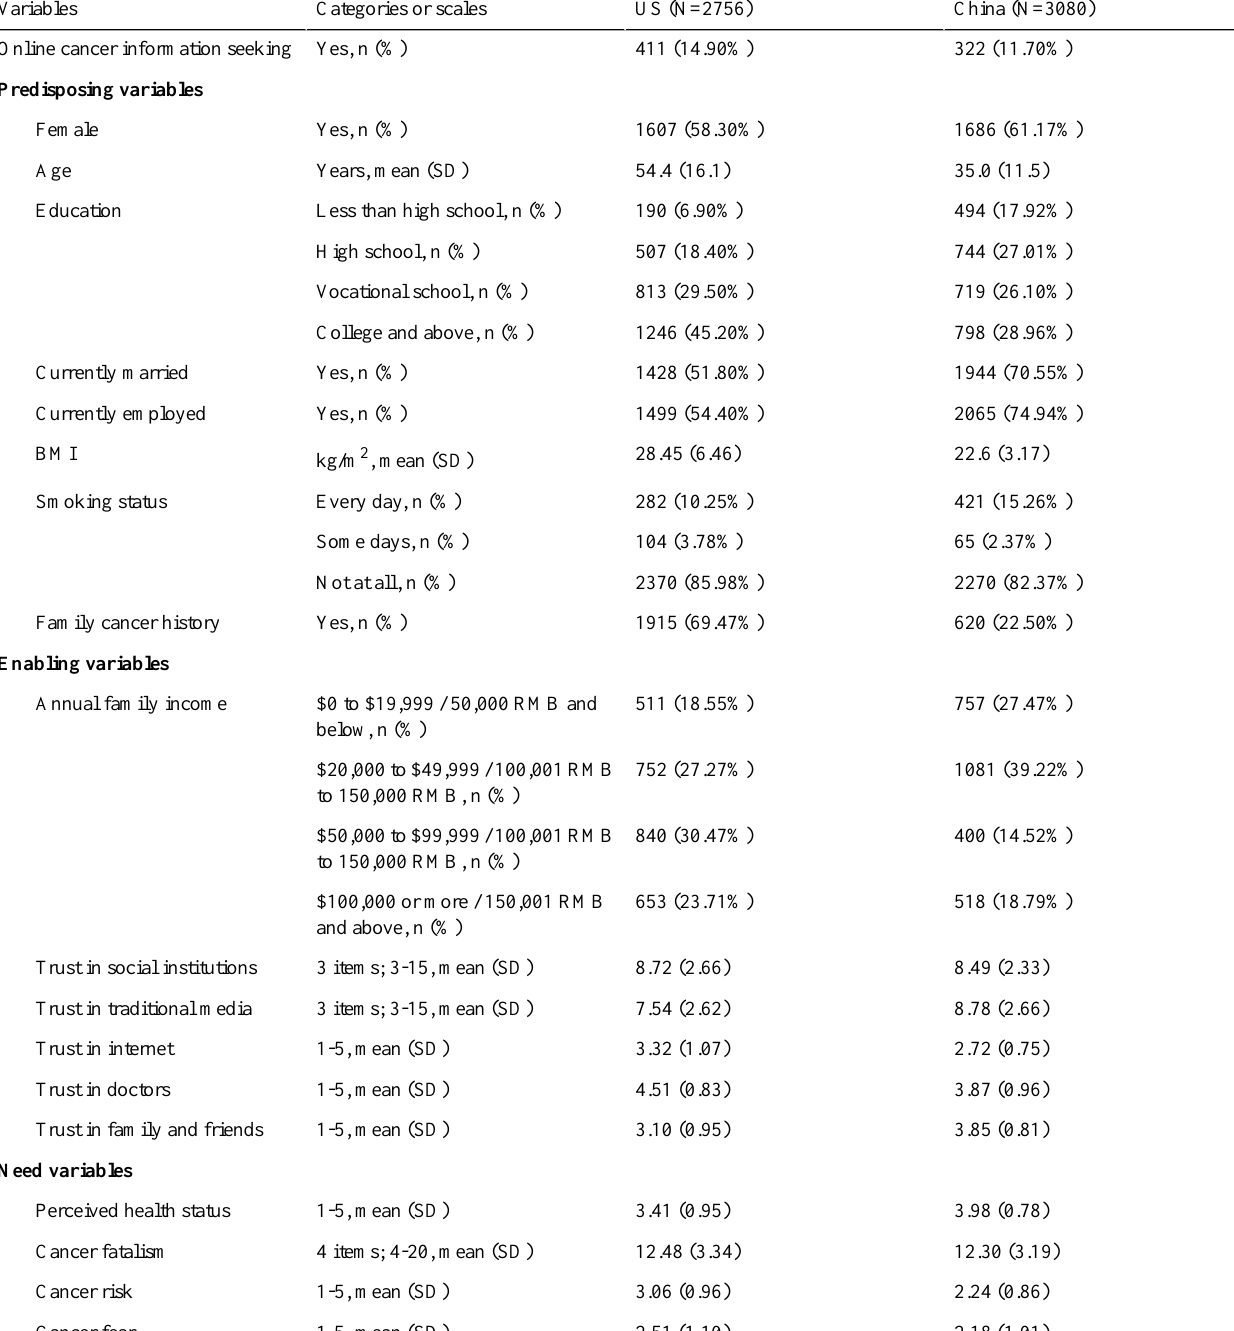
Table 2. Descriptive statistics of dependent and independent variables for cancer-free respondents of the Health Information National Trends Survey (HINTS) 2017 and the HINTS-China